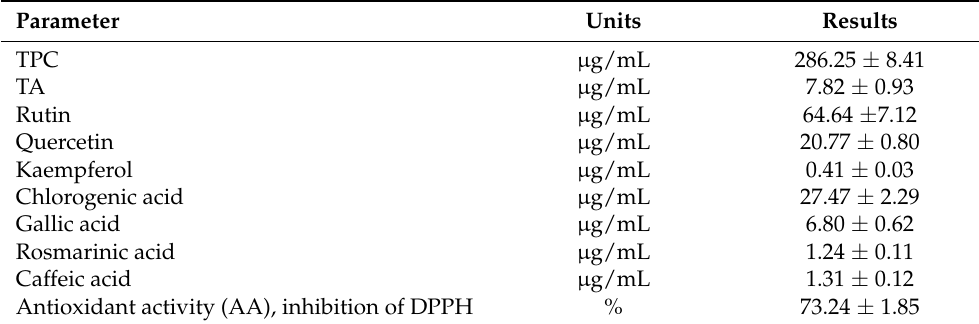
Table 2. The concentration of the antioxidant phenolic compounds in the apple/berry (chokeberries, blueberries, cranberries) juice used in the present